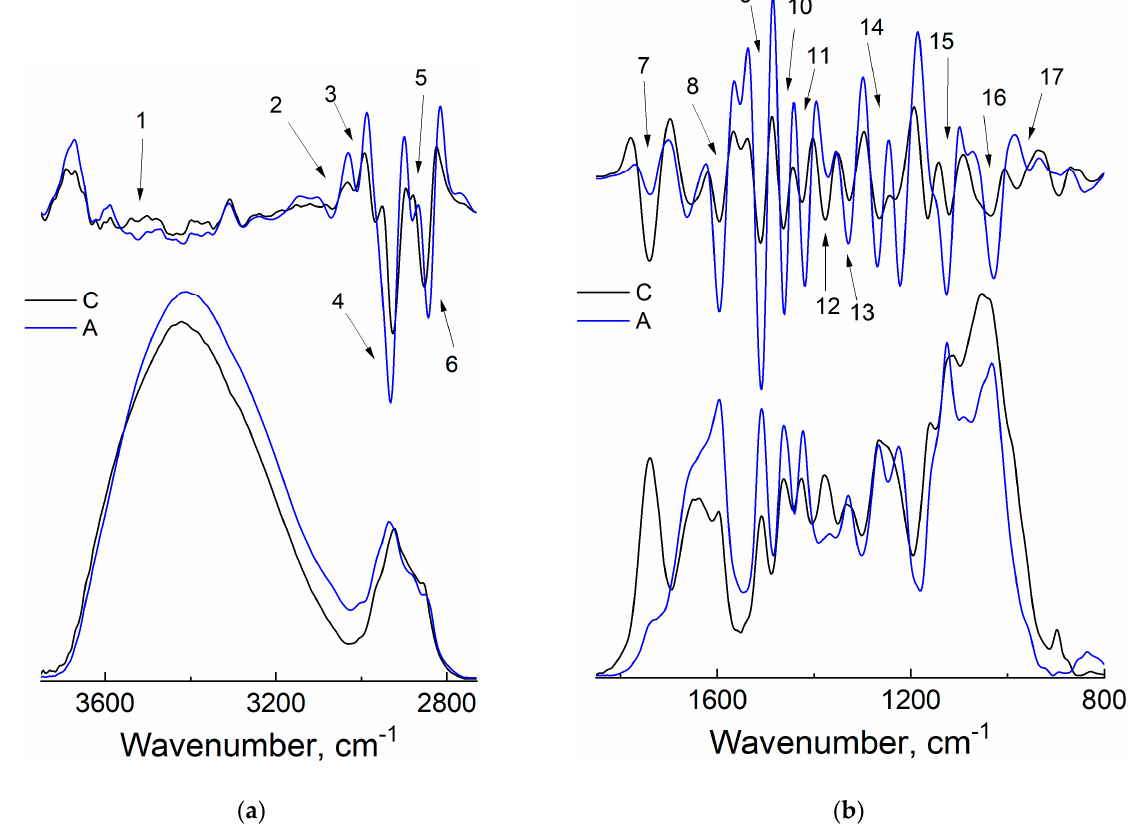
Figure 3. Infrared spectra and their derivatives for the control (C) and the archaeological (A) elm wood samples in 3750–2750 cm − 1 ( a ) and 1850–800 cm − 1 ( b )